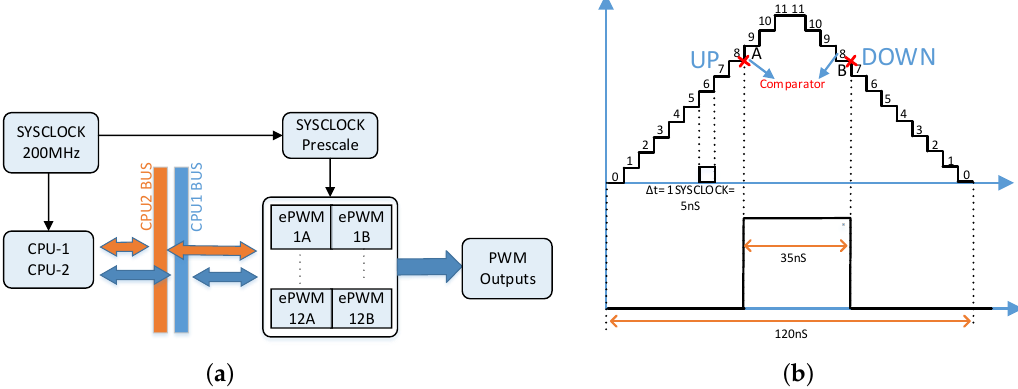
Figure 6. ( a ) PWM block operation diagram. ( b ) PWM signal generation with Up-Down type